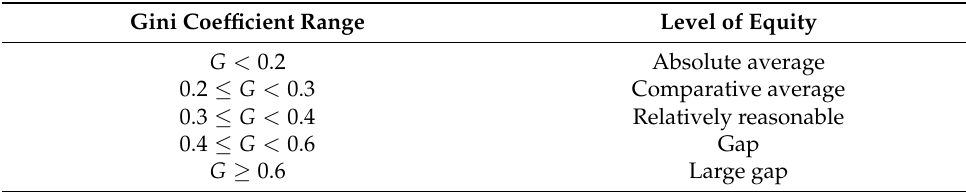
Table 2. Gini coefficient range and